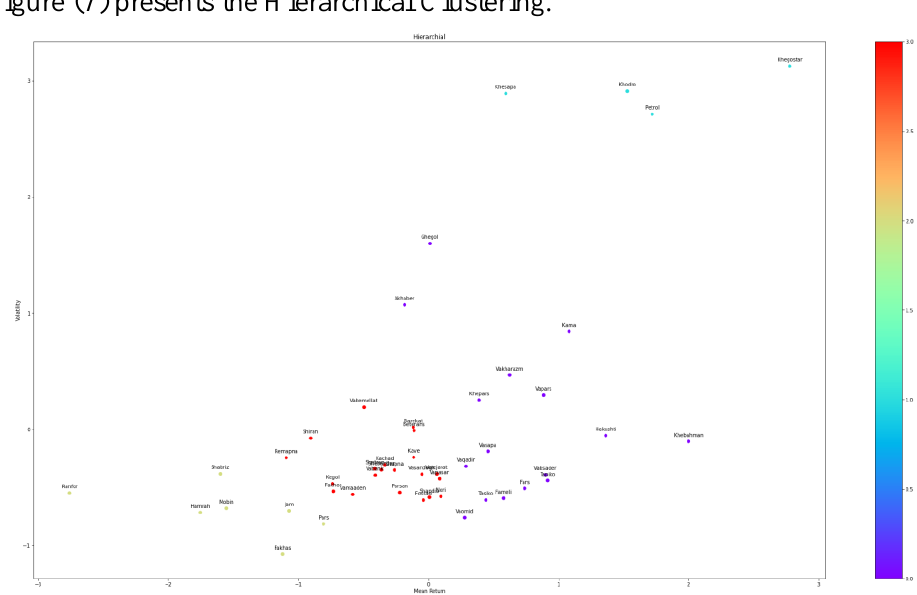
Figure 7. Hierarchical